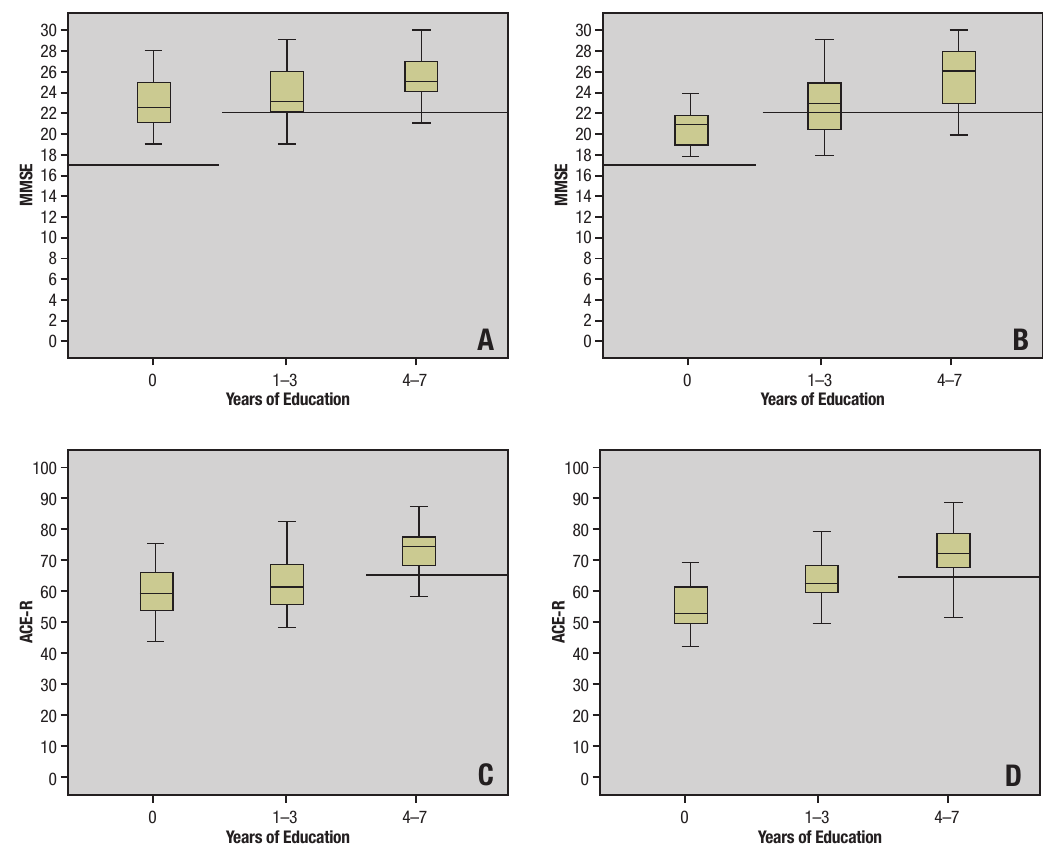
Figure 1. [A] Median MMSE performance of healthy group participants stratified by years of education. Cut-off point is 17 for illiterates and 22 for 1